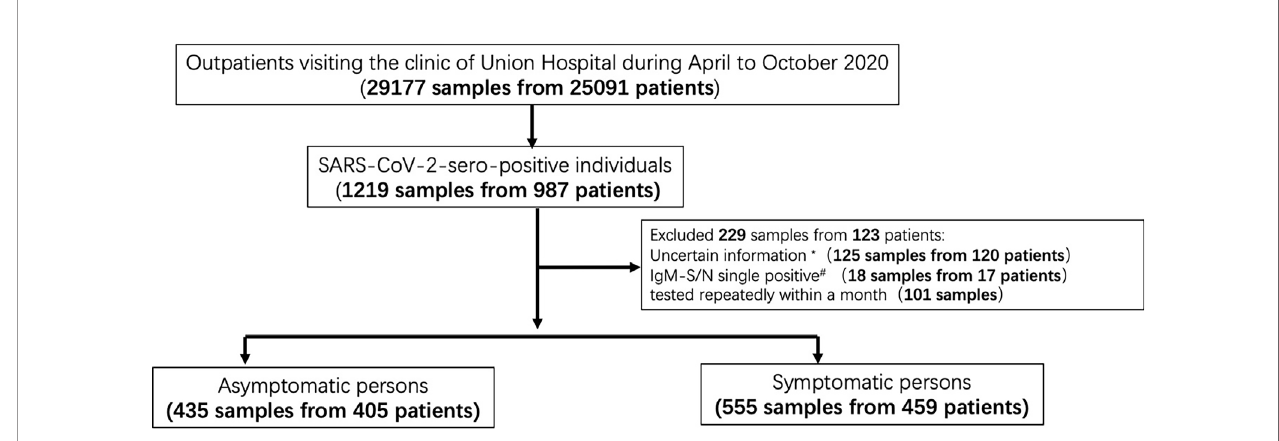
FIGURE 1 | Study population, cohort enrolment process, exclusion criteria, and work fl ow of surveillance and analysis. Please note that there was an overlap between exclusion criterion 1* ( ‘ uncertain information ’ ) and 2 # ( ‘ IgM single positivity ’